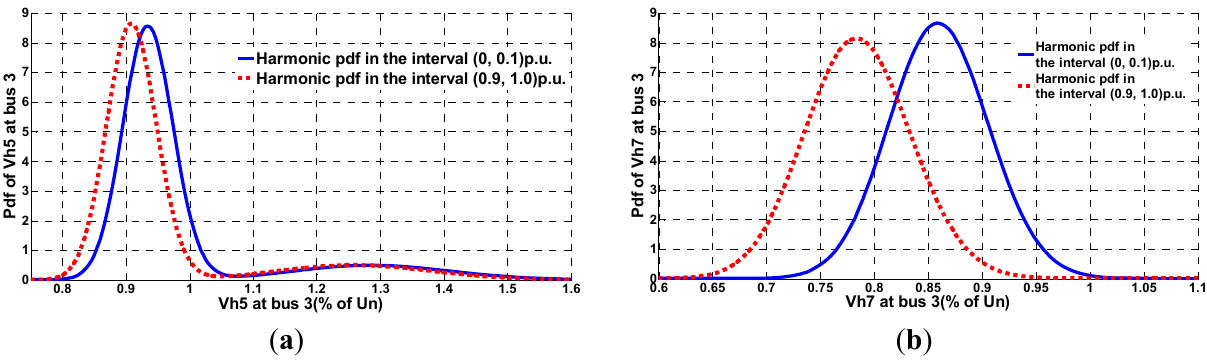
Figure 14. Pdfs of the harmonic voltages at bus 3 in different intervals. ( a ) The fifth harmonic voltage magnitude; ( b ) The seventh harmonic voltage